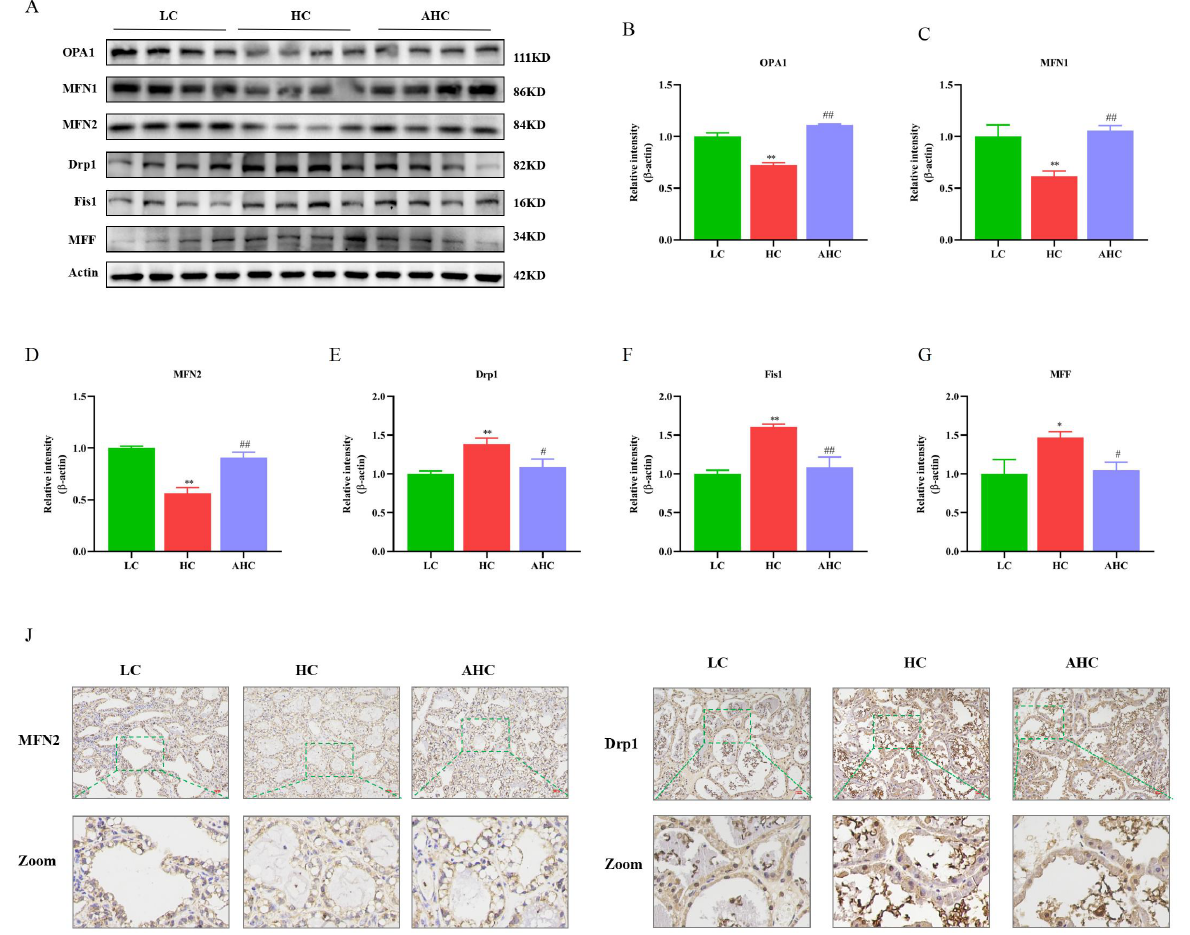
Figure 5. The effects of disodium fumarate on mitochondrial dynamics in the mammary glands of Hu sheep induced by the high-concentrate diet. Representative bands of the proteins associated with mitochondrial fusion and division ( A ); quantified volumes of specific bands ( B – G ); data are presented as the relative protein abundances relative to actin (means ± SEM), * p < 0.05, ** p < 0.01 represent significant differences compared with the LC diet. # p < 0.05, ## p < 0.01 represent significant differences compared with the HC diet. Immunohistochemical results of MFN2 ( H ) and Drp1 ( I ) in the mammary gland tissue of Hu sheep. The bar = 100 µ m. The green line represents zooming in on the selected area of the